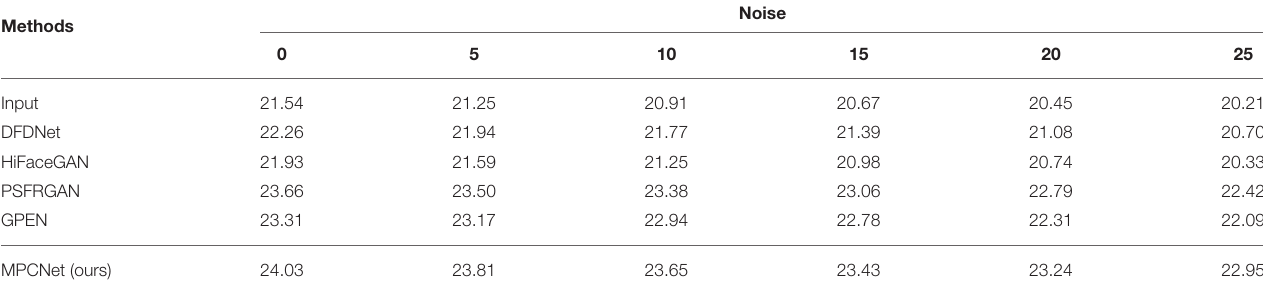
TABLE 6 | Peak signal-to-noise ratio results achieved on CelebA-Test degraded by different level noises. Methods